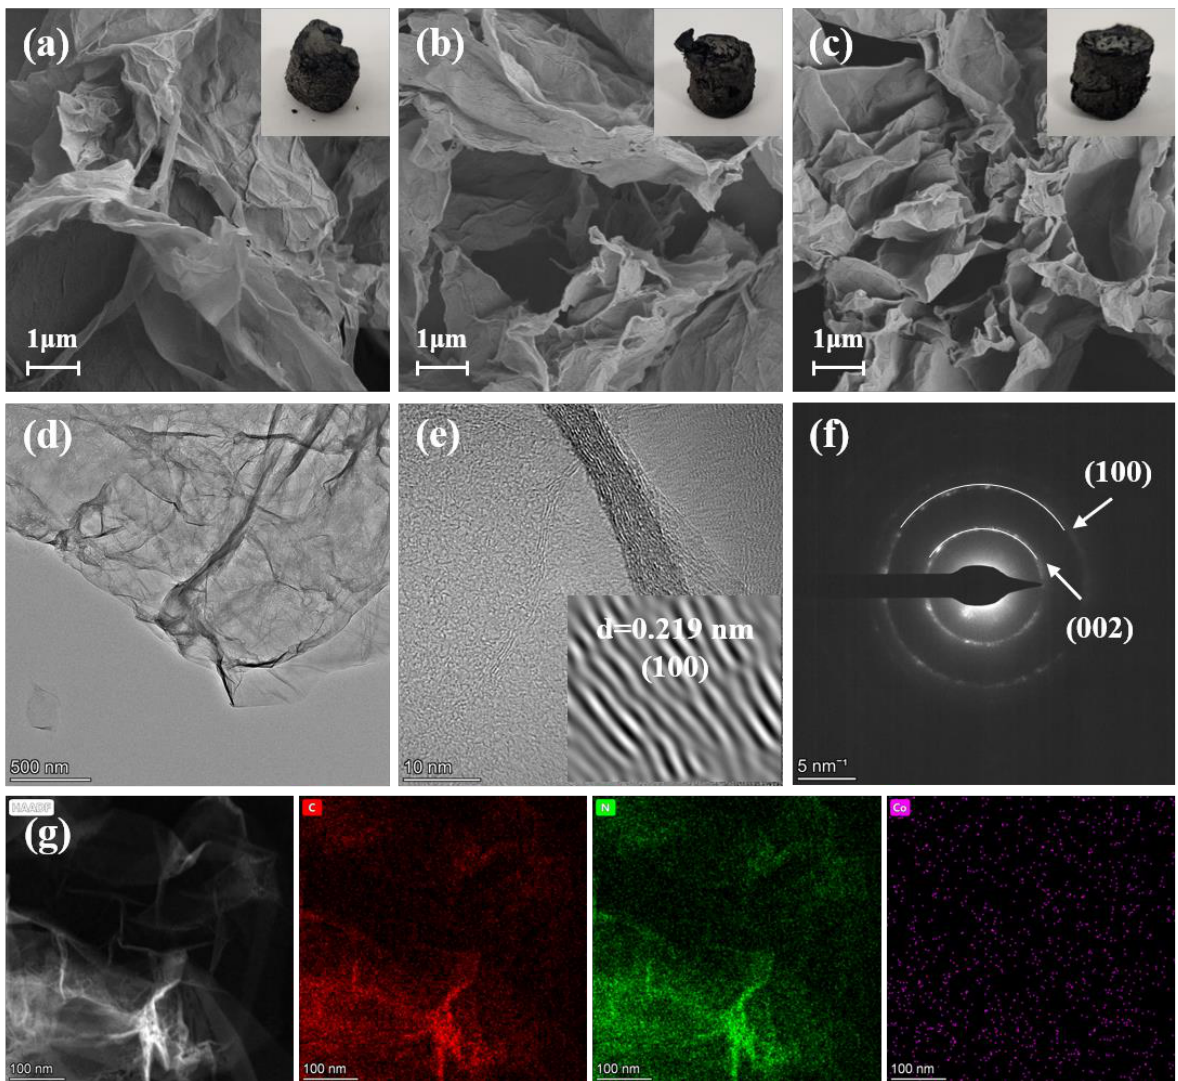
Figure 3. ( a – c ) SEM and physical photographs of GA, Co-C, and Co-N-C, respectively. ( d , e ) TEM, ( f ) SAED, and ( g ) mappings of Co-N-C.